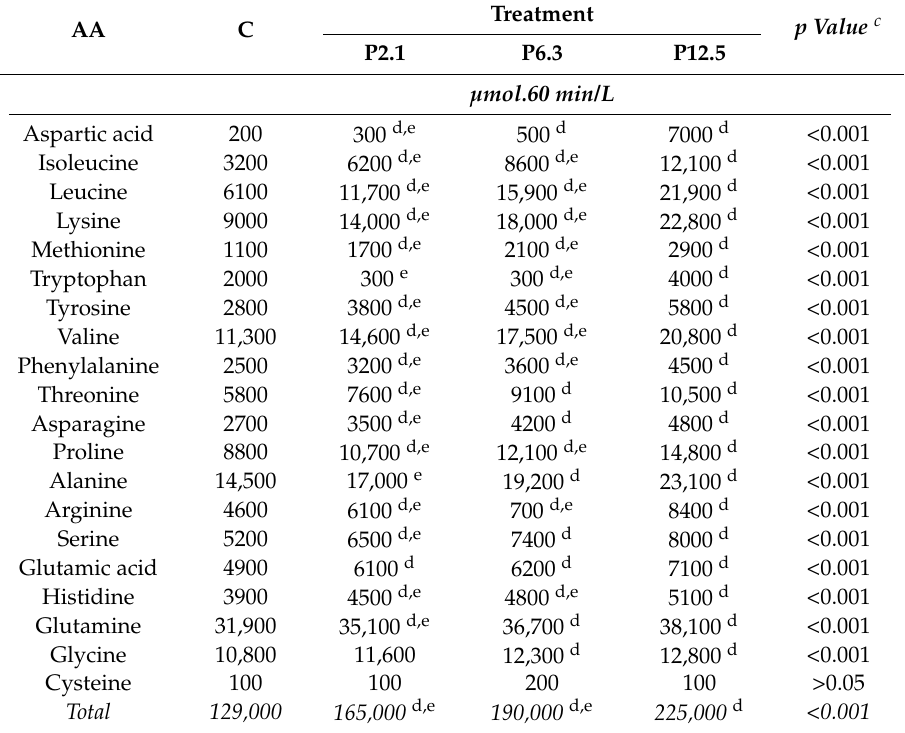
Table 3. Plasma amino acid (AA) responses (AUC 0 ´ 60 min ) ordered from the strongest to weakest response following the infusions, relative to control a,b,c